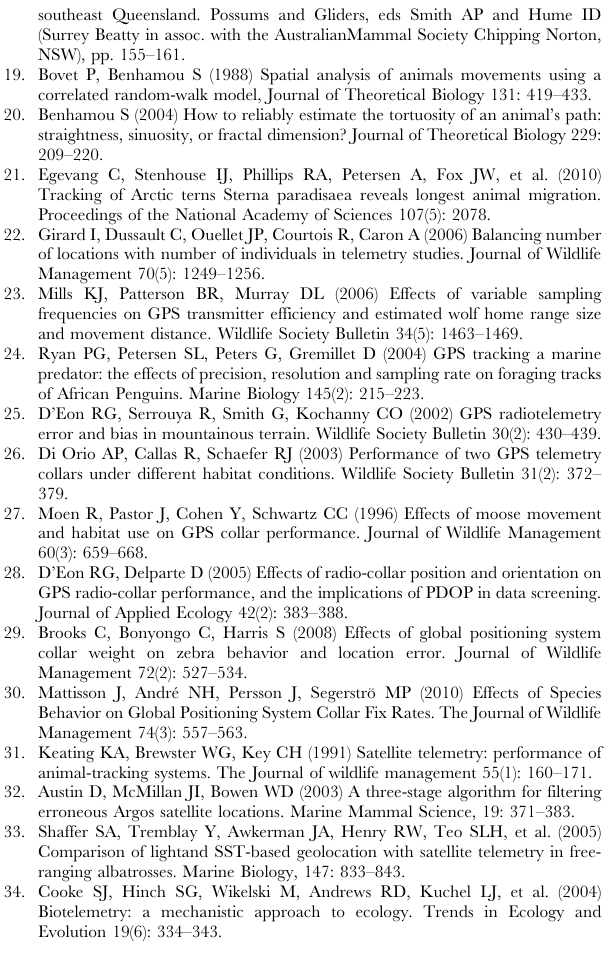
Table S1 Table showing posterior parameter values for possum # 1882 for all three models, and each sub- sampling